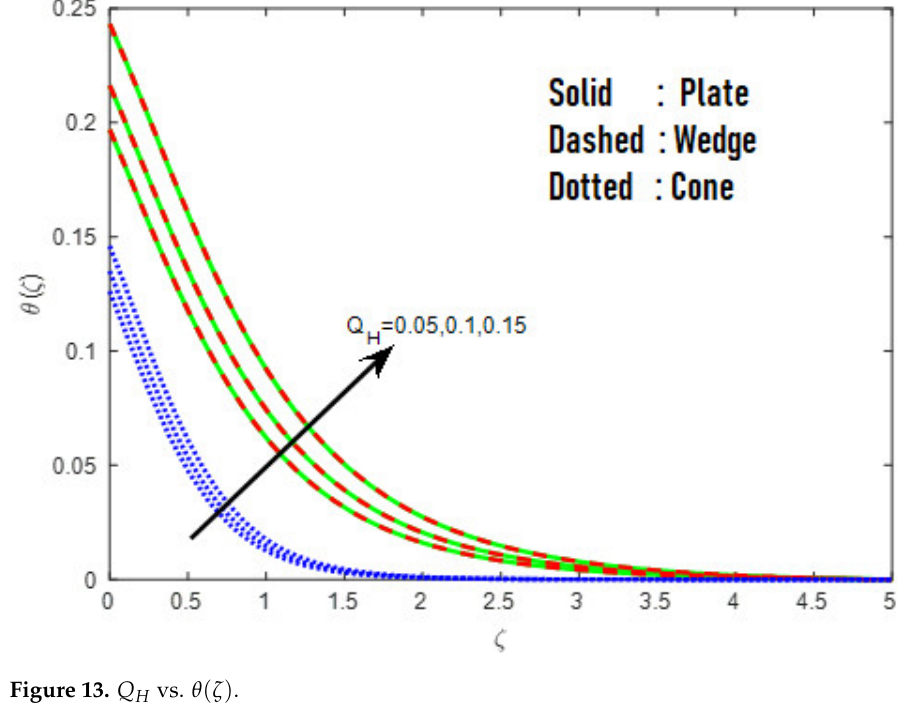
Q vs.     . Figure 13. Q H vs. θ ( ζ ) . Figure 13. H Figure 13. H